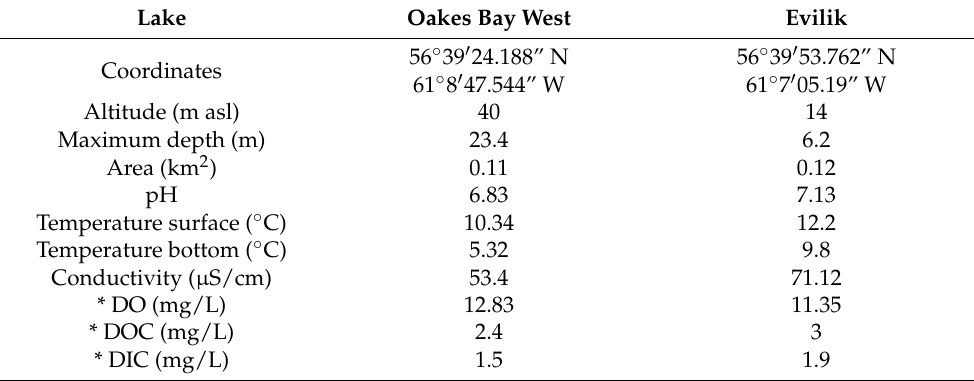
Table 1. Summary of physicochemical characteristics of Oakes Bay West and Evilik lakes (16 July 2019). Lake Oakes Bay West